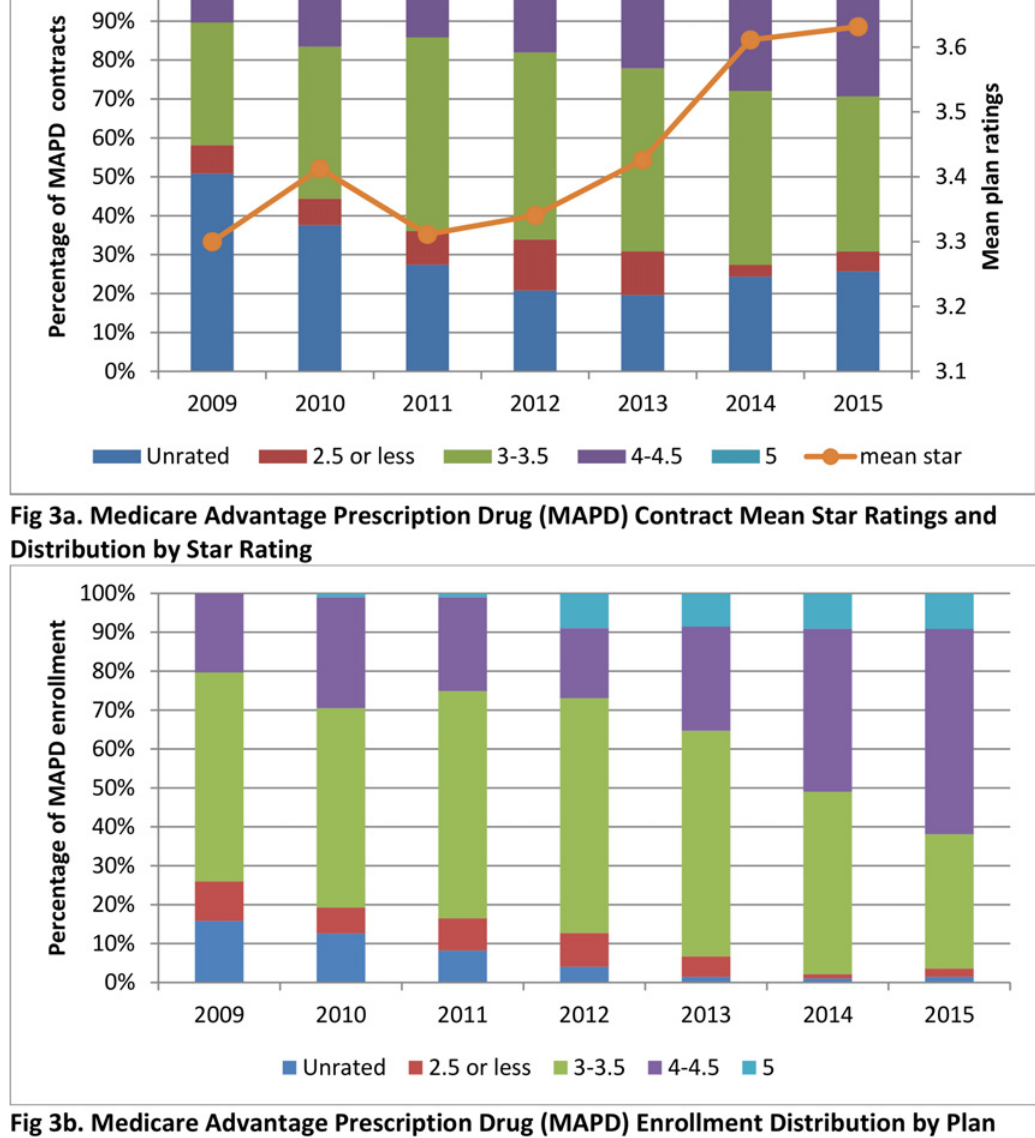
Fig 3. Medicare Advantage Contracts Star Ratings and Enrollment: 2009 to